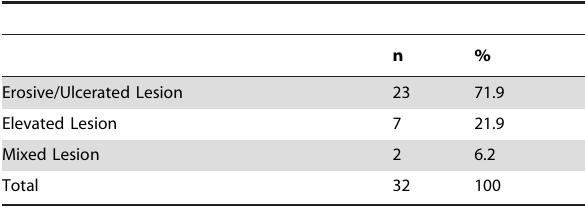
Table 2. Specific colonoscopic findings in patients with an abnormal colon.